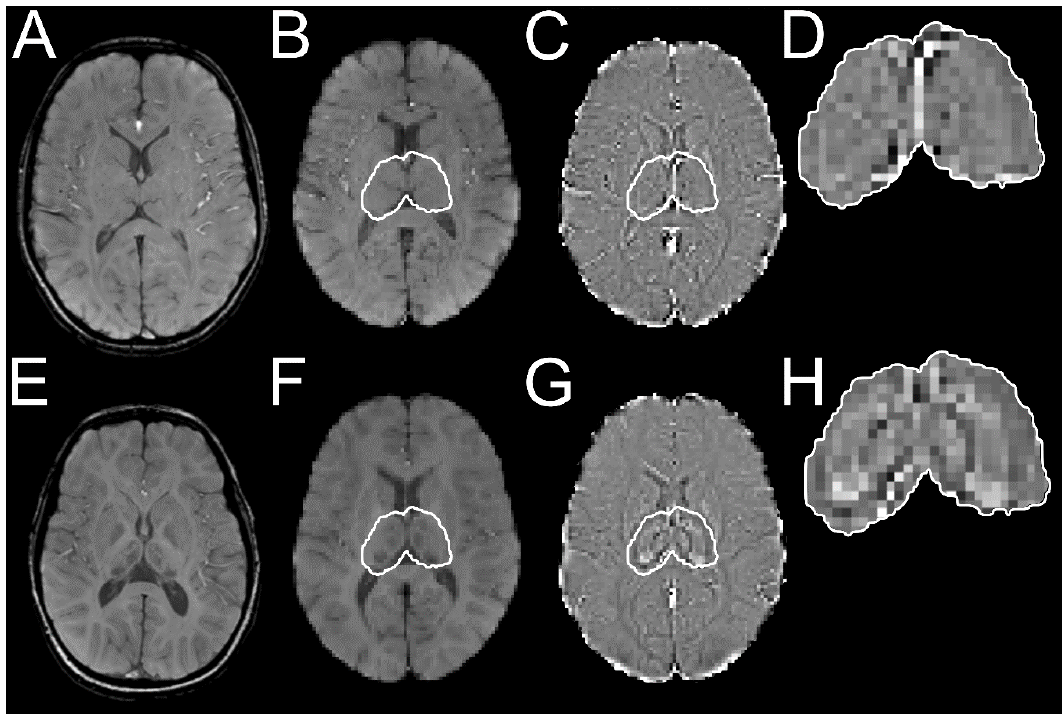
Figure 1. Visualization of the segmentation pipeline of the whole thalamus. An axial slice from a control is shown on the upper row. ( A ) Magnitude susceptibility-weighted images (SWI) are registered to MN152 space shown in ( B ) where the thalamus is highlighted with a white contour. ( C ) The obtained transformations are applied to phase-filtered SWI for the segmentation shown in ( D ), from which the average and voxel-wise thalamic intensities are derived. Respective steps for a patient with aspartylglucosaminuria (AGU) depict iron accumulation in ( E – H ). Iron is seen as an intensity decrease in magnitude images ( E , F ) or an intensity increase in the phase-filtered images ( G , H ).